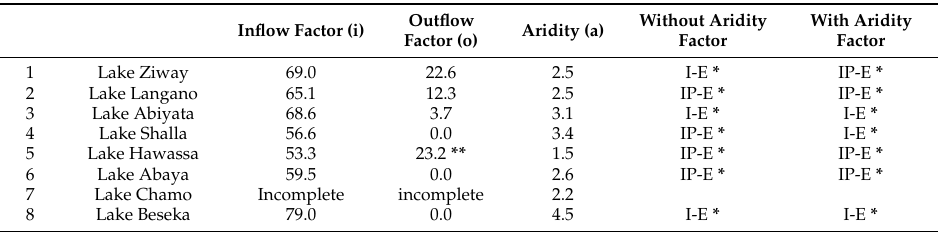
Table 3. Results of inflow, outflow, aridity, and the corresponding